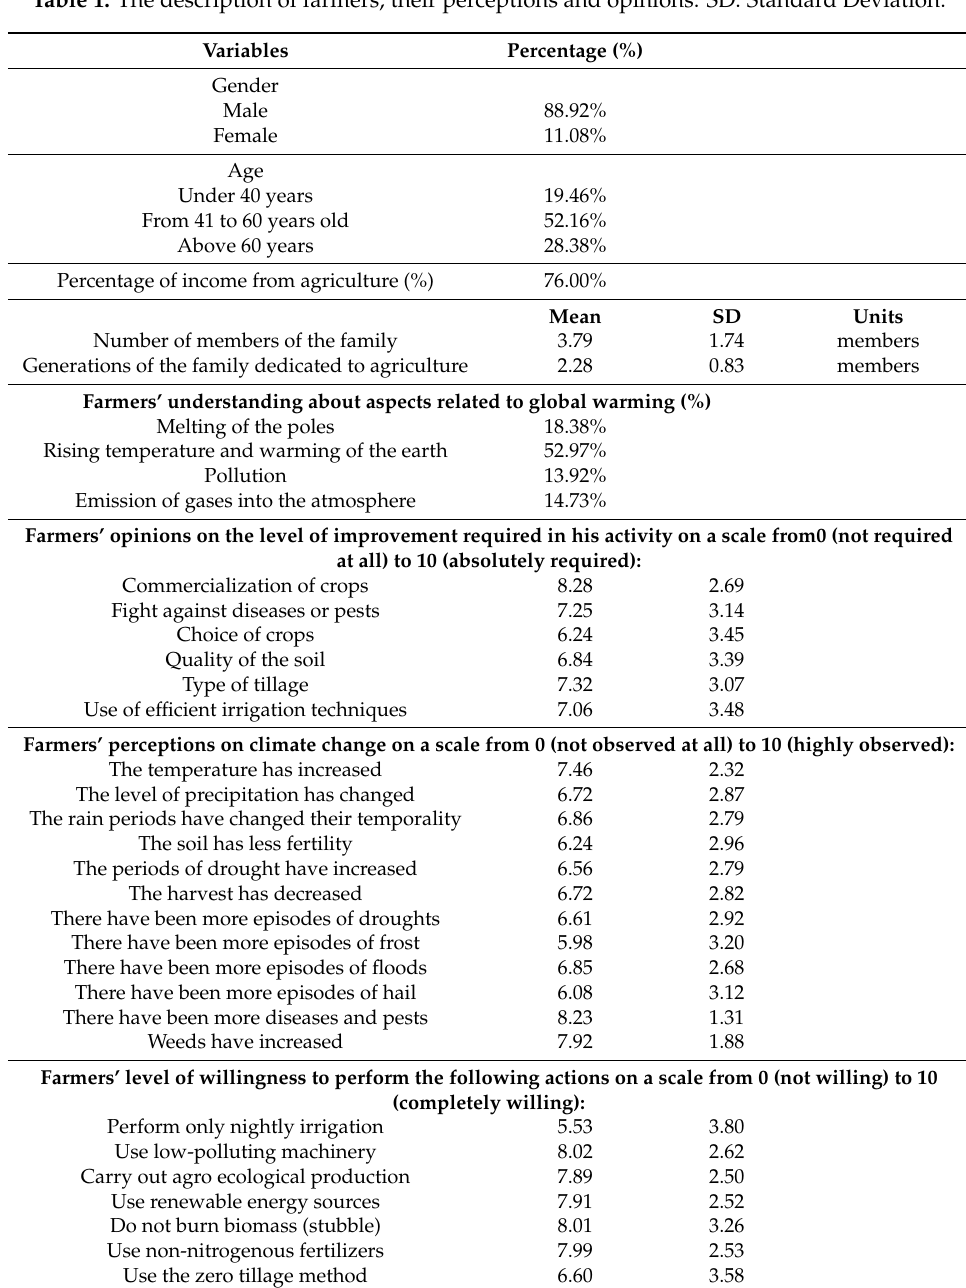
Table 1. The description of farmers, their perceptions and opinions. SD: Standard